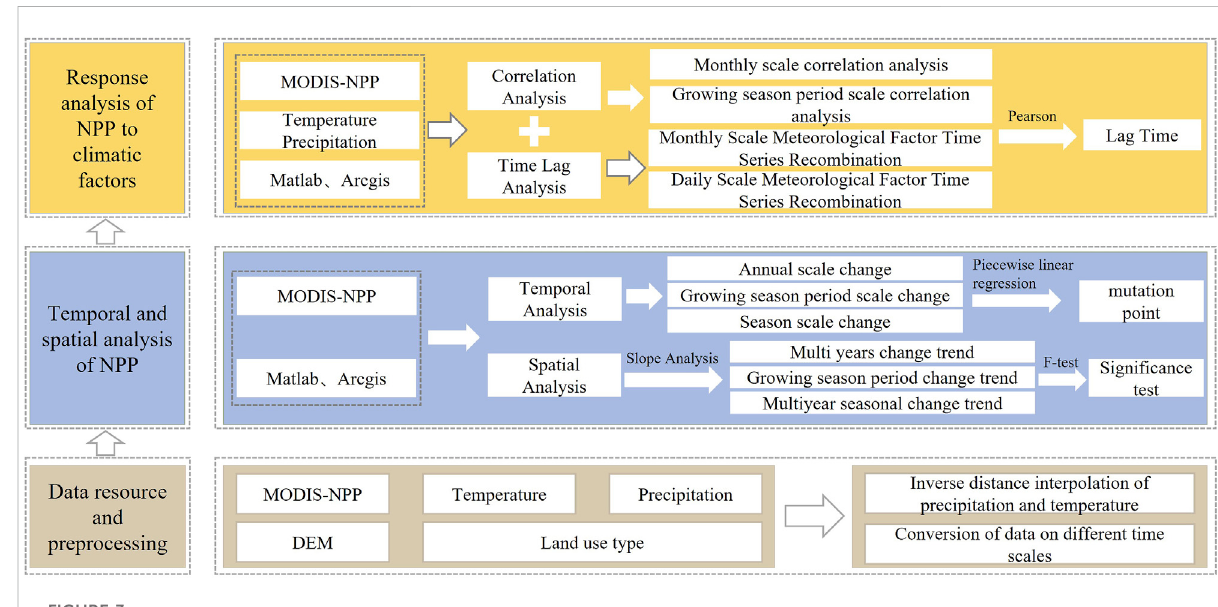
FIGURE 3 Logical framework